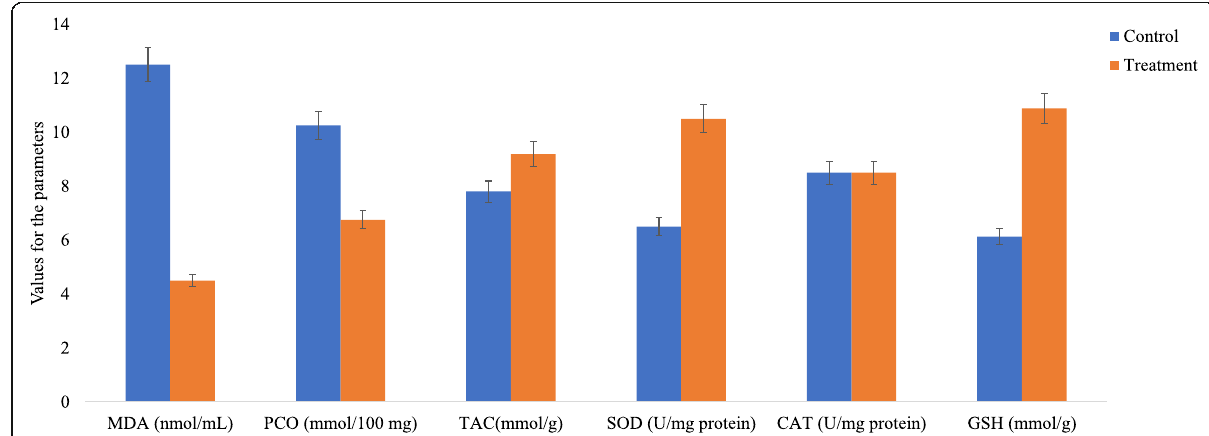
Fig. 1 Comparative concentration of oxidative stress biomarkers in the liver of the rabbits. The biomarkers determined in the liver were malondialdehyde (MDA), protein carbonyl (PCO), total antioxidant capacity (TAC), superoxide dismutase enzymes (SOD), catalase (CAT) activities, and glutathione concentration (GSH) which were used as measurement for determining the oxidative stress status of the rabbits. Control group were not supplemented while the treatment group were rabbits supplemented with 500 mg Chlorella vulgaris biomass per kg bodyweight of the